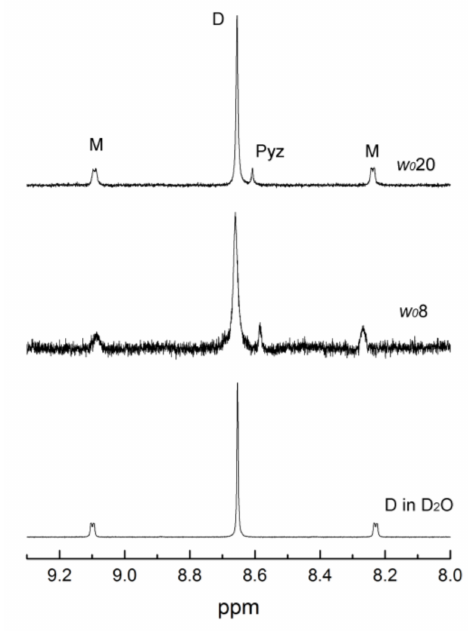
Figure 7. 1 H-NMR spectra were recorded at 300 MHz of a pH 9.0 solution D (0.020 mM) in aqueous solution and in 0.75 M AOT/isooctane RMs at w 0 sizes 8, 10 and 20. All spectra were taken within 30 min of